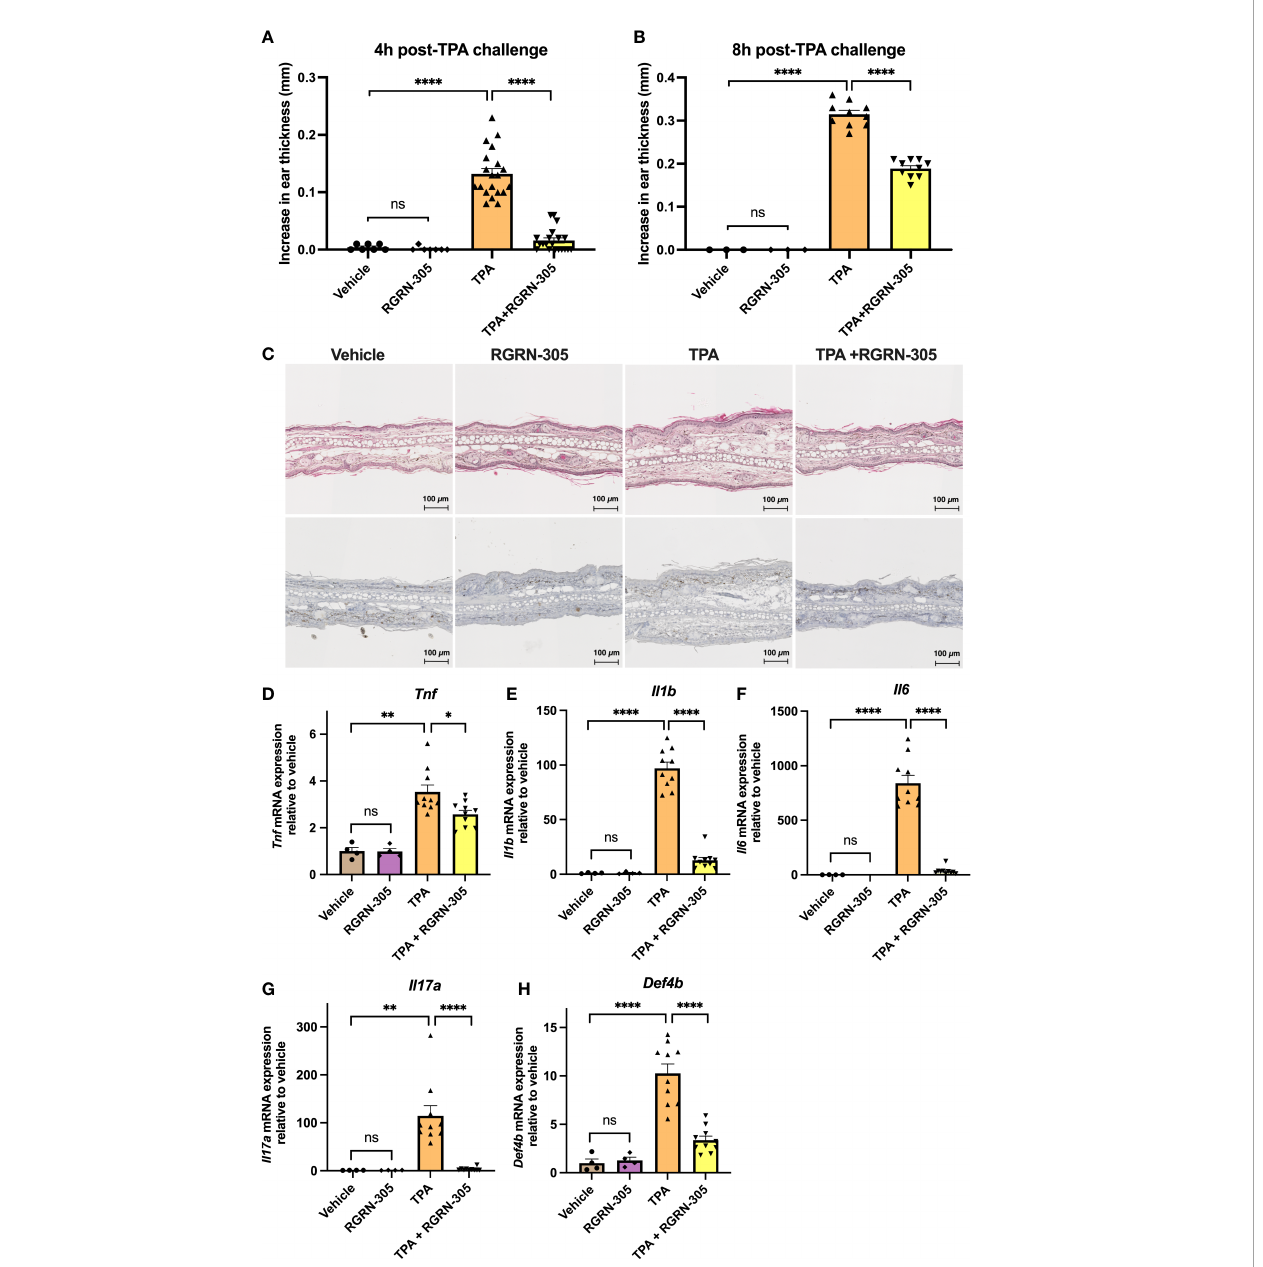
FIGURE 4 Effects of RGRN-305 on skin in fl ammation elicited by TPA in mice. C57BL/6 mice were pretreated topically with 1 mg/ear RGRN-305 or vehicle (acetone) 100 minutes before challenge with 2.5 µg TPA or vehicle. Two independent experiments were conducted. Total number of mice in treatment groups: vehicle = 7, RGRN-305 = 7, TPA = 20, TPA+RGRN-305 = 20. (A, B) Ear thickness change measured 4 (A) and 8 hours (B) post-TPA challenge. (C) Representative images of hematoxylin and eosin (upper panel) and Ki-67 (lower panel) stained histological sections of mice ears collected 4 hours post-TPA challenge (four to ten mice per treatment group). (D – H) mRNA expression of indicated proin fl ammatory cytokines measured by RT-qPCR in mice ear punch biopsies collected 4 hours post-TPA challenge (four to ten mice per treatment group, n = 28). Data are shown as mean ± SEM fold change relative to vehicle.*p < 0.05, **p ≤ 0.01, ***p ≤ 0.001, ****p ≤ 0.0001. TPA,